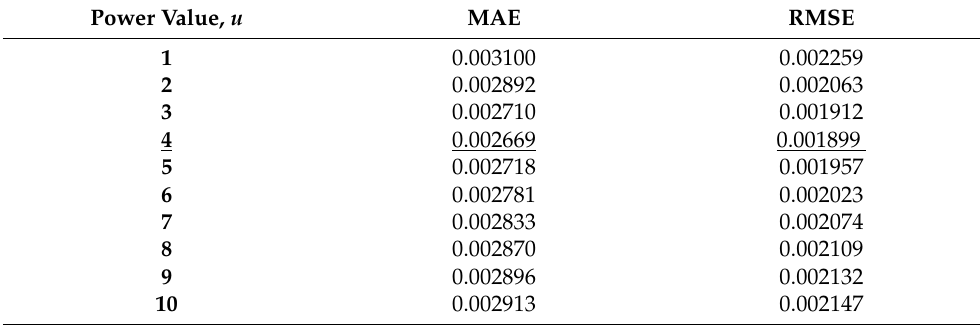
Table 5. MAE and RMSE for different power